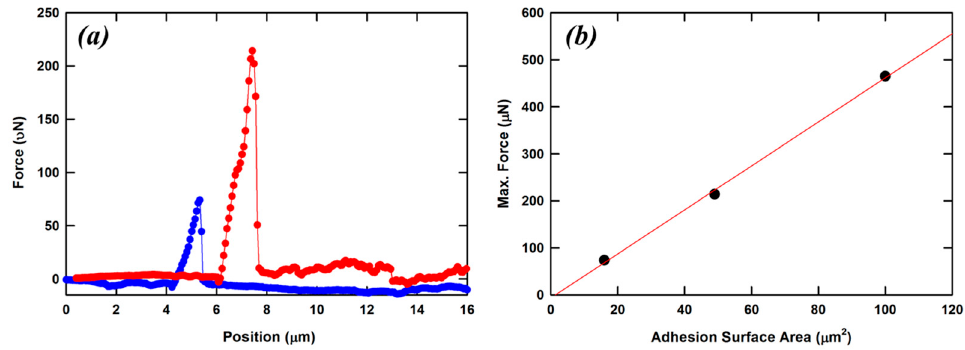
Figure 8. Lateral force measurements of cubes fabricated by TPP onto glass substrate ( a ). Forces applied to a cube with the side 4 µm long are represented with circles; forces applied to a cube with a side 7 µm long are represented with triangles. The solid lines are intended only as a guide to the eye. Maximum force required to dislodge a polymer cube from its substrate is a function of the contact surface area ( b ). The solid line is a linear regression. Reproduced from [29].